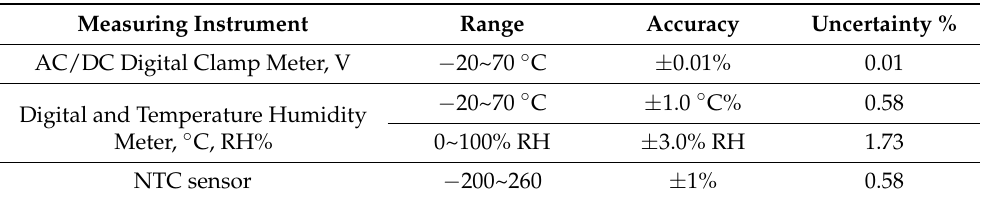
Table 1. The accuracy and uncertainty of various instruments. Measuring Instrument Range Accuracy Uncertainty